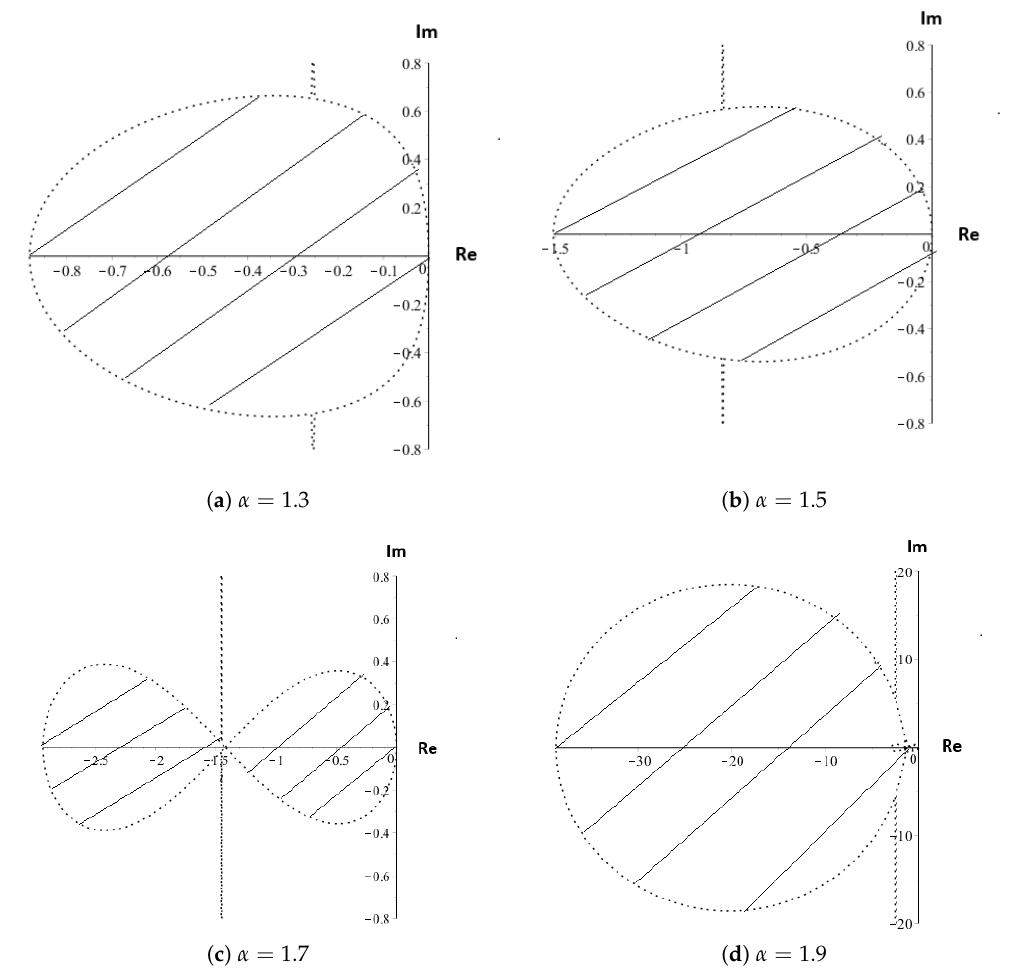
Figure 3. Stability region for FEAM3 when 1 < α <